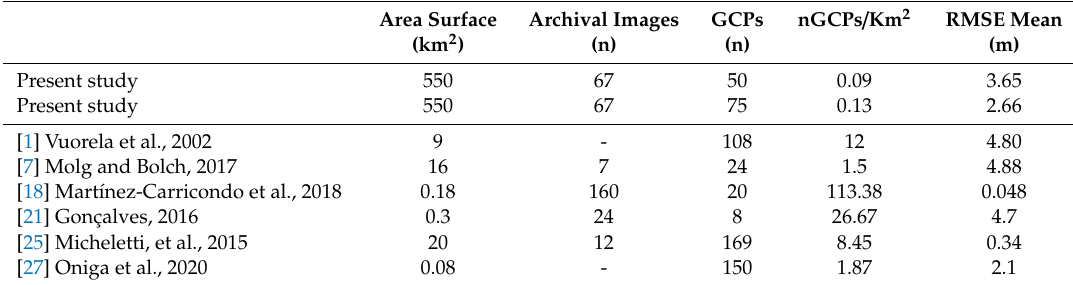
Table 11. Comparison between the present study and the